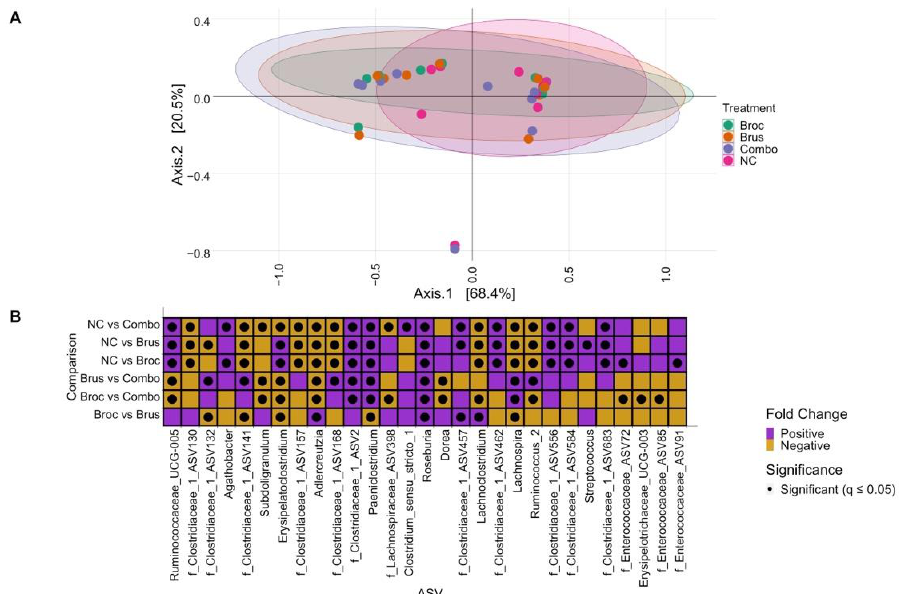
Figure 2. Cruciferous vegetables do not alter β -diversity but do impact individual ASVs. ( A ) Principal coordinates analysis (PCoA) showing beta diversity of samples. Each point represents one sample, with the color of the point indicating the treatment group. Ellipses represent the multivariate t-distribution of each treatment group. ( B ) ASVs significantly different between treatment groups, as determined using a negative binomial generalized linear mixed model. The x-axis represents each genus, and the y-axis represents each pairwise comparison. f_ASV# indicates an unannotated genus of the family shown. Comparisons are organized as Group 1 vs. Group 2; purple squares represent a positive log 2 fold change, indicating Group 1 is more abundant than Group 2, while orange squares represent a negative fold change, indicating Group 2 is more abundant than Group 1. Black dots within the squares signify significant (q ≤ 0.05) differential abundance.